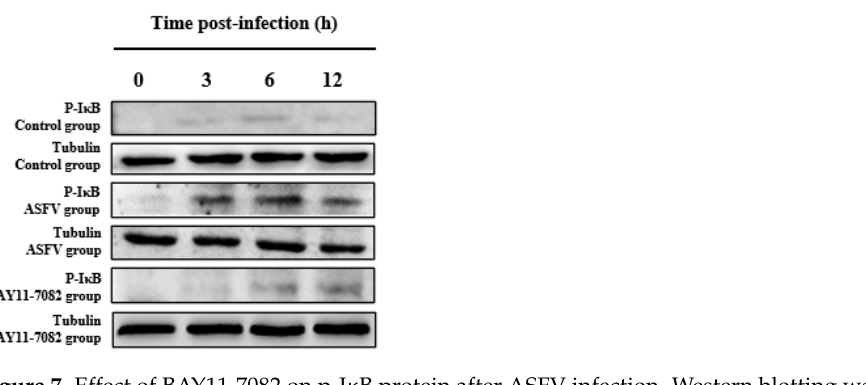
fection time from 3 to 12 h. In the experimental group, the NF- κ B inhibitor (BAY11-7082) was added at the same time as when PAMs cells were inoculated with ASFV. Compared